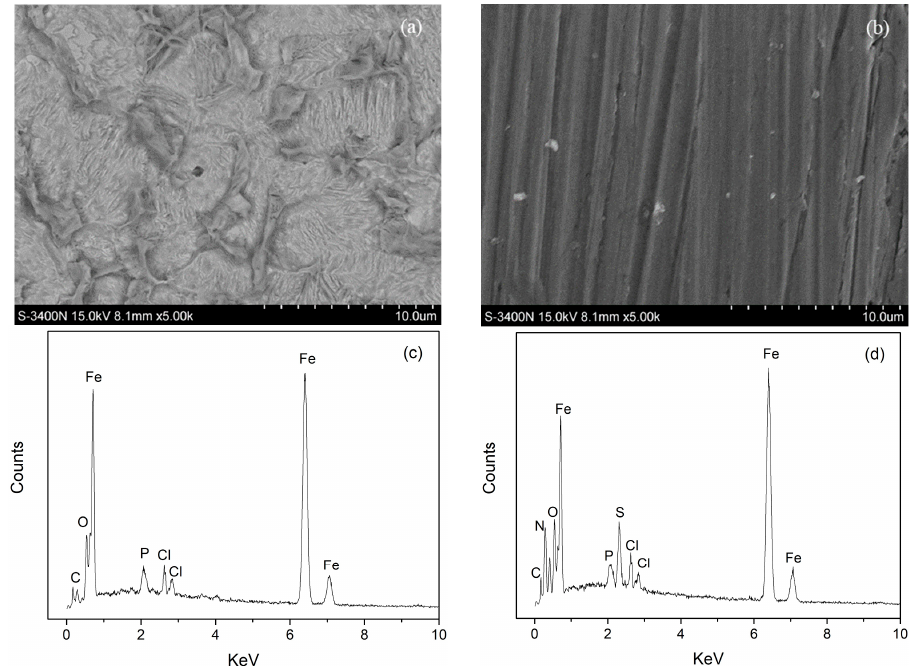
Figure 9. SEM micrographs and EDS results of carbon steel immersed in 1 M HCl solutions without TSCA ( a , c ) and with 40 mg/L TSCA ( b , d ) for 1 h at 298 K.